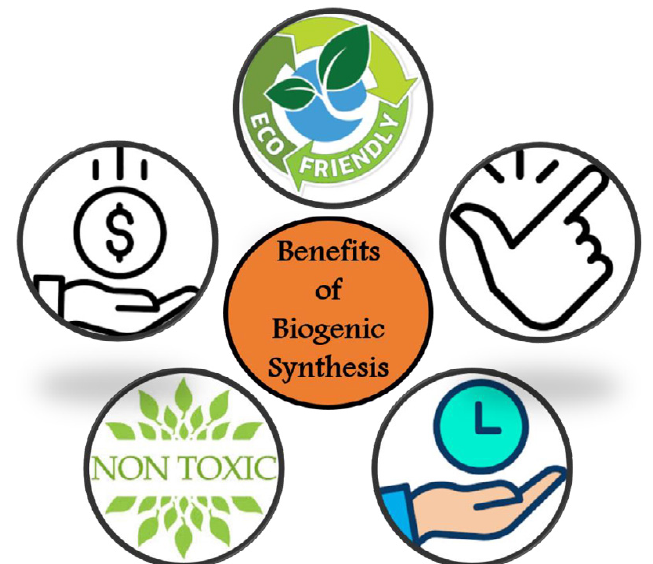
Fig. 3. Benefits of green synthesis in